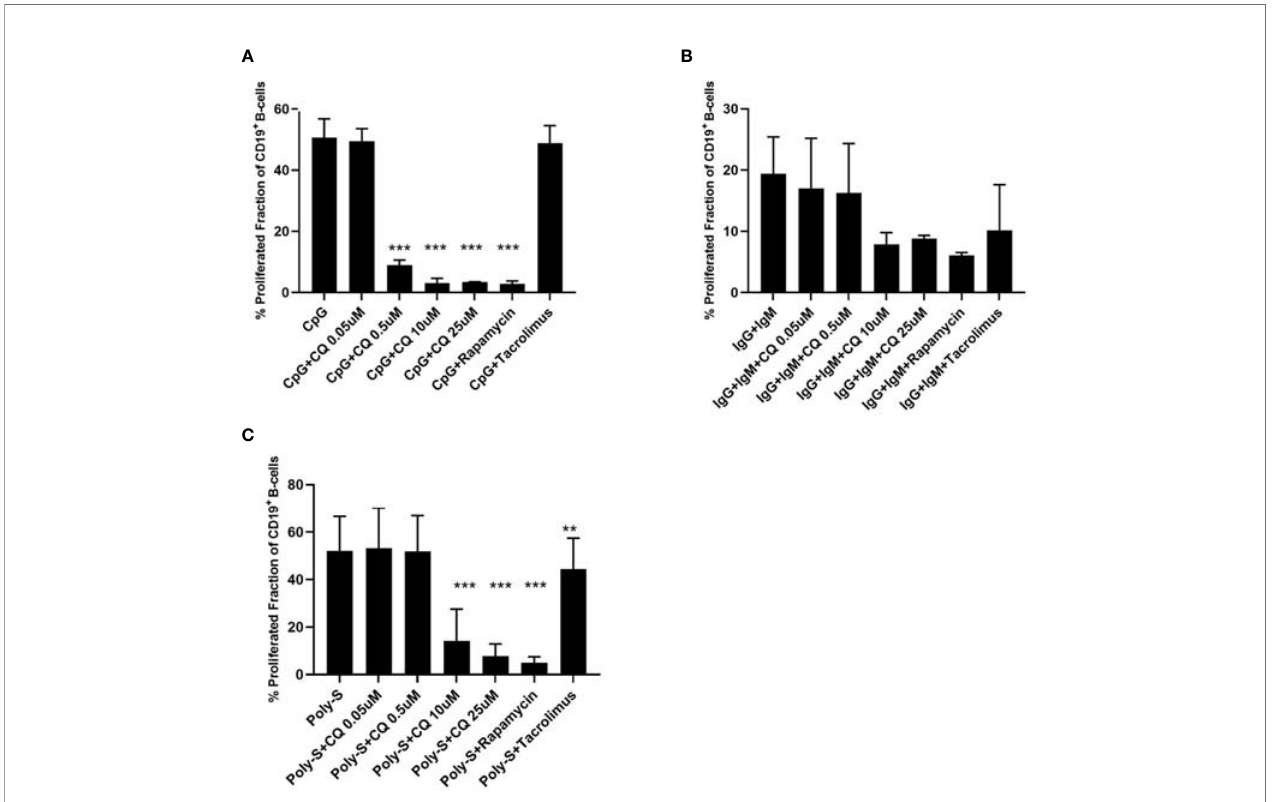
FIGURE 2 | CQ affects B-cell proliferation depending on the stimulus. PBMCs were isolated and labeled with CFSE followed by stimulation with different stimuli in presence of CQ at four concentrations (0.05 µM, 0.5 µM, 10 µM, 25 µM). Rapamycin and tacrolimus were also used as controls. After 72 hours, CD19 + B-cell proliferation was determined by CFSE-dilution. (A) Impact of CQ on B cell proliferation upon stimulation with CpG. (B) Impact of CQ on B cell proliferation upon IgM/ IgG stimulation. (C) Impact of CQ on B cell proliferation upon Poly-S stimulation. P-values were calculated by repeated-measures ANOVA and correction for multiple comparisons were done by Dunnett ’ s test. **p < 0.01, ***p < 0.0001 (against CpG, IgG+IgM or Poly-S as control